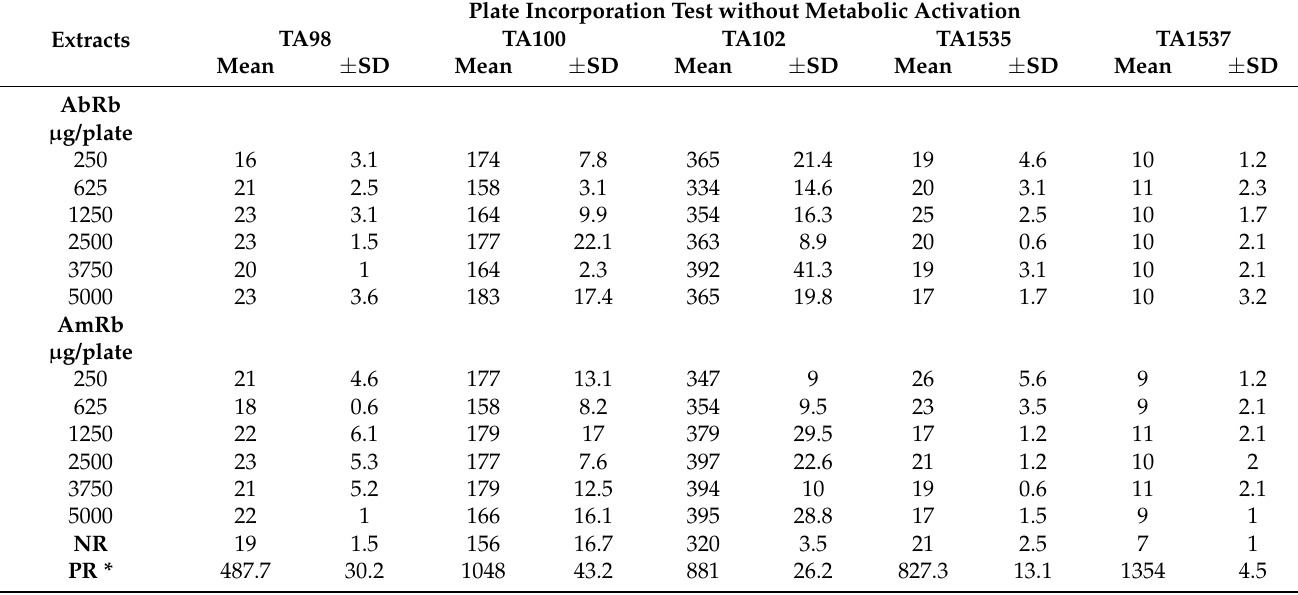
Table 3. Mutagenicity of root extracts in the bacterial reverse mutation test (Ames